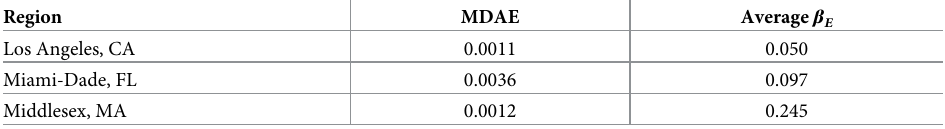
Table 3. Comparison of the MDAE value and average β regions with different